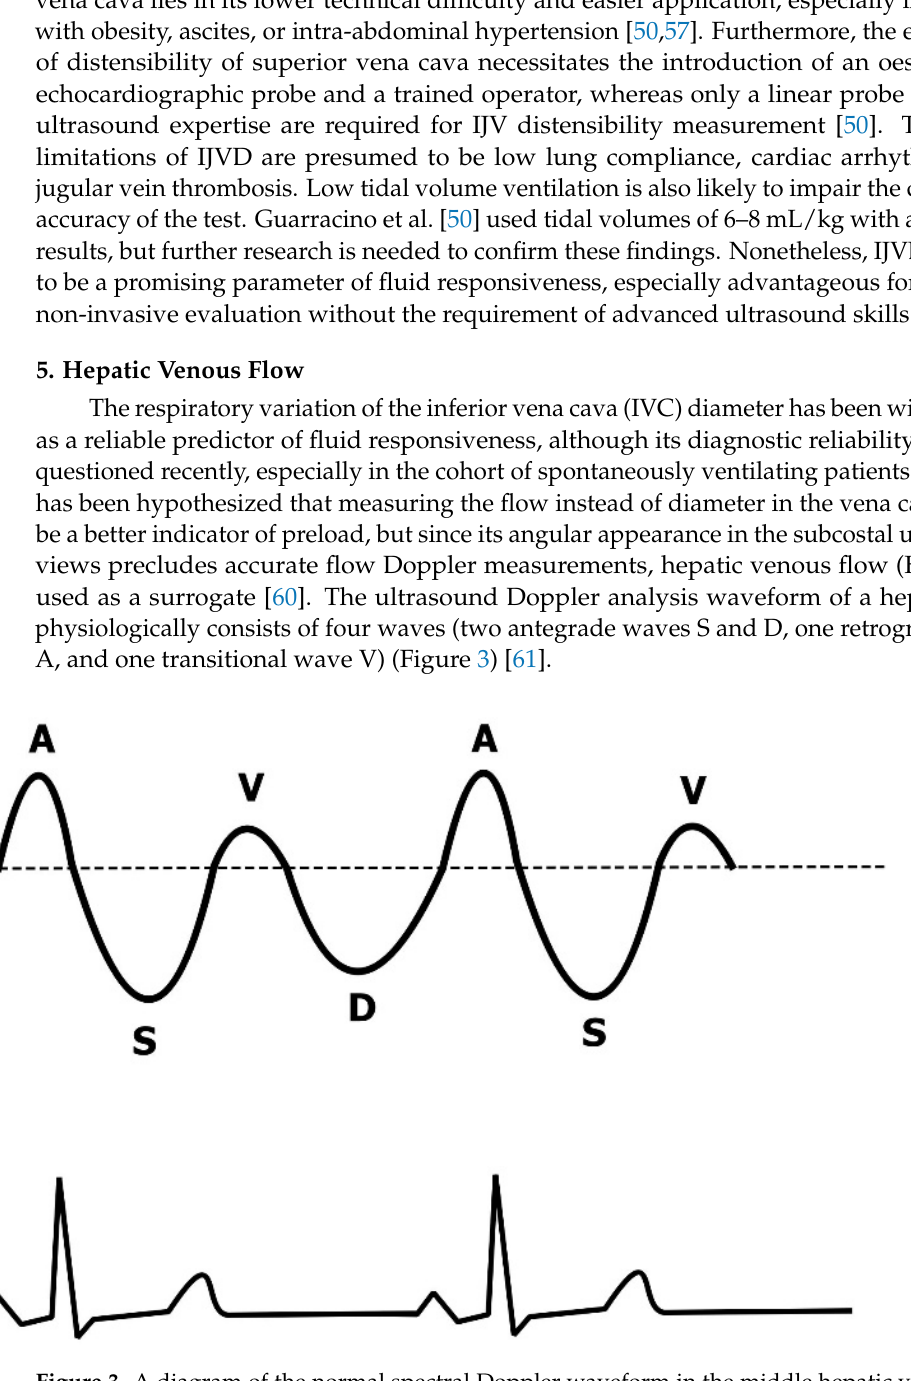
Figure 3. A diagram of the normal spectral Doppler waveform in the middle hepatic vein (MHV) correlated with a concurrent ECG tracing. During the cardiac cycle, atrial systole results in a retrograde flow of blood toward the liver, producing the A wave. The S wave is seen during ventricular systole, when antegrade blood flow in the MHV is produced as the tricuspid valve moves toward the cardiac apex. Afterwards, the tricuspid valve returns to its original position and the retrograde V wave is seen. Ventricular diastole is associated with passive blood inflow from the atria, producing the D wave.